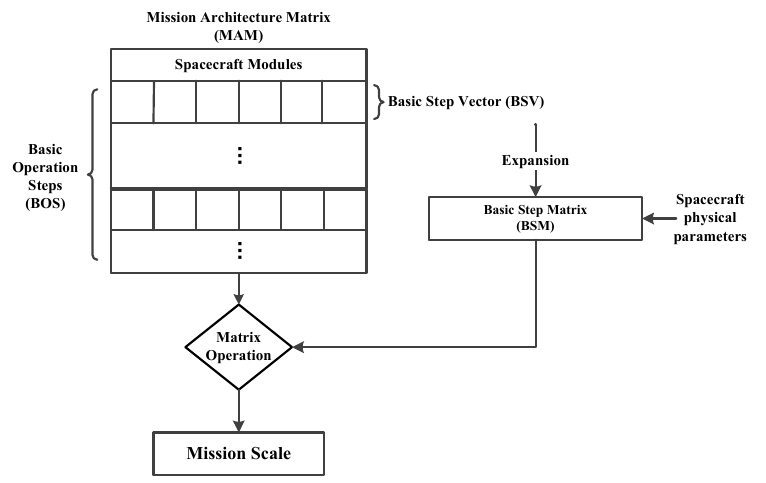
Figure 1. Schematic diagram of the MAM